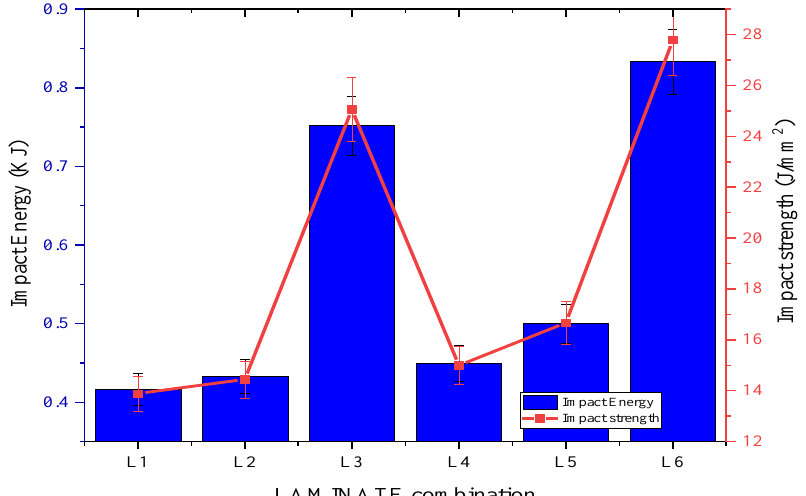
Figure 6. Energy absorbed and impact strength of laminates subjected to Izod’s impact test.